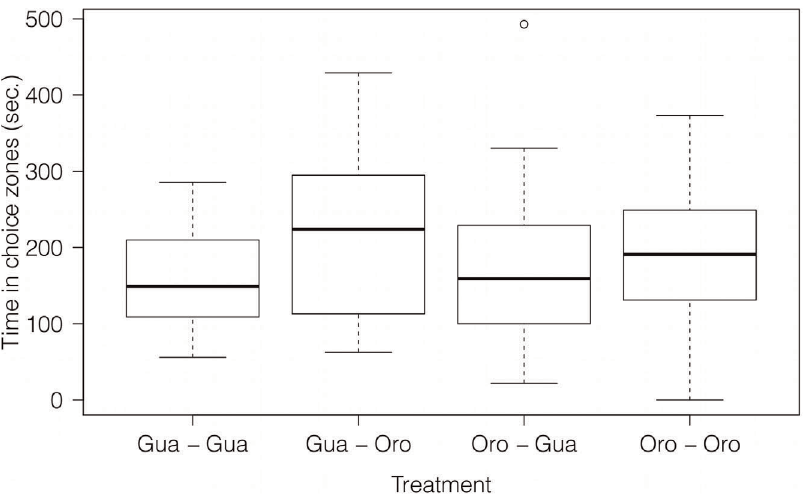
Figure 2. Shoaling times of Guanapo and Oropuche females. The amount of time focal females from either the Guanapo or Oropuche spent shoaling with fish from their own or the other population. Medians and interquartile ranges are shown.